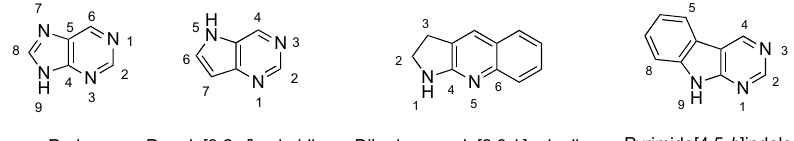
Figure 1. Structures of biologically relevant heterocycles.